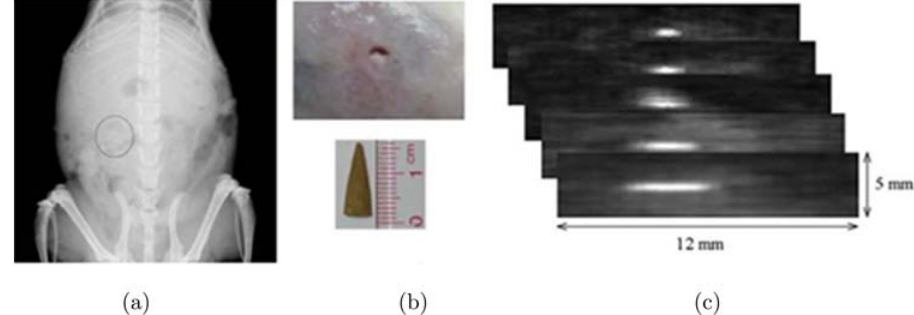
Fig. 14. Comparison of foreign body detection between TAI and X-ray imaging. (a) X-ray imaging of the living mouse with the bamboo. (b) Photographs of the mouse and the bamboo strip. (c) Five TA images along the vertical direction of the bamboo strip. 84